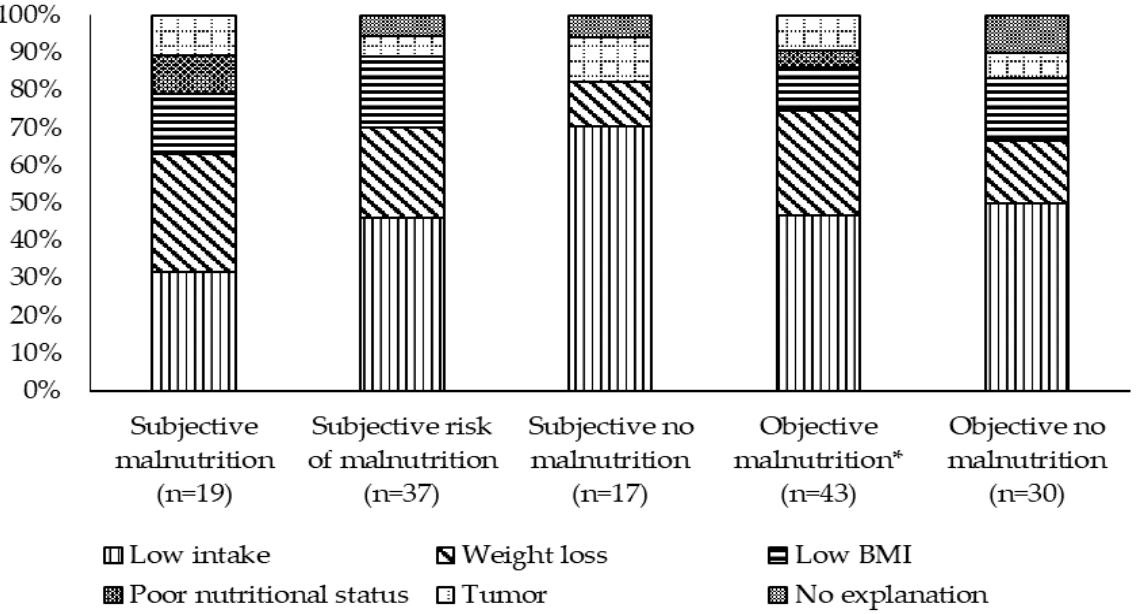
Figure 2. Reasons for nutritional interventions (%) stratified by subjective judgement of malnutrition by nursing staff and objective rating of malnutrition (* BMI < 20 kg/m 2 or weight loss ≥ 5% in last 3 months or intake ≤ 1/4 of the meal).